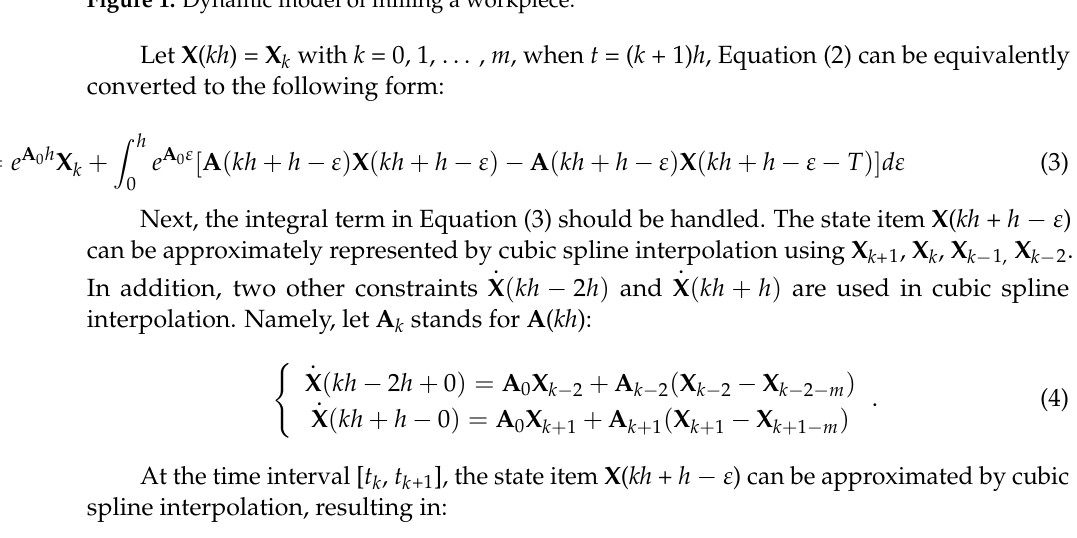
Figure 1. Dynamic model of milling a workpiece.